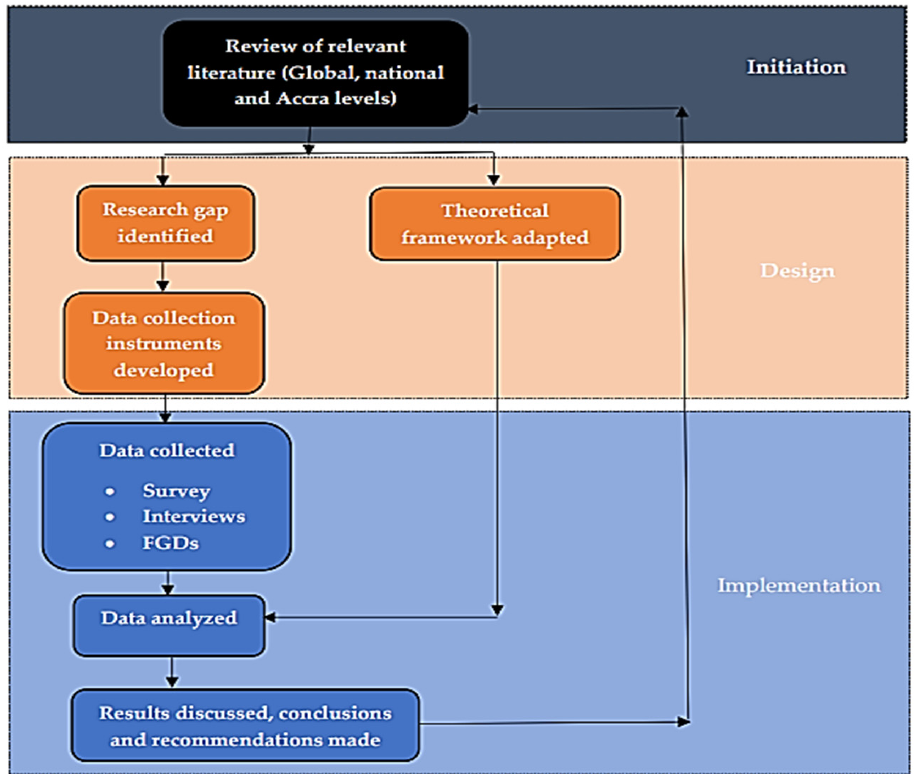
Figure 3. Research flowchart. Source: Authors’ construct.